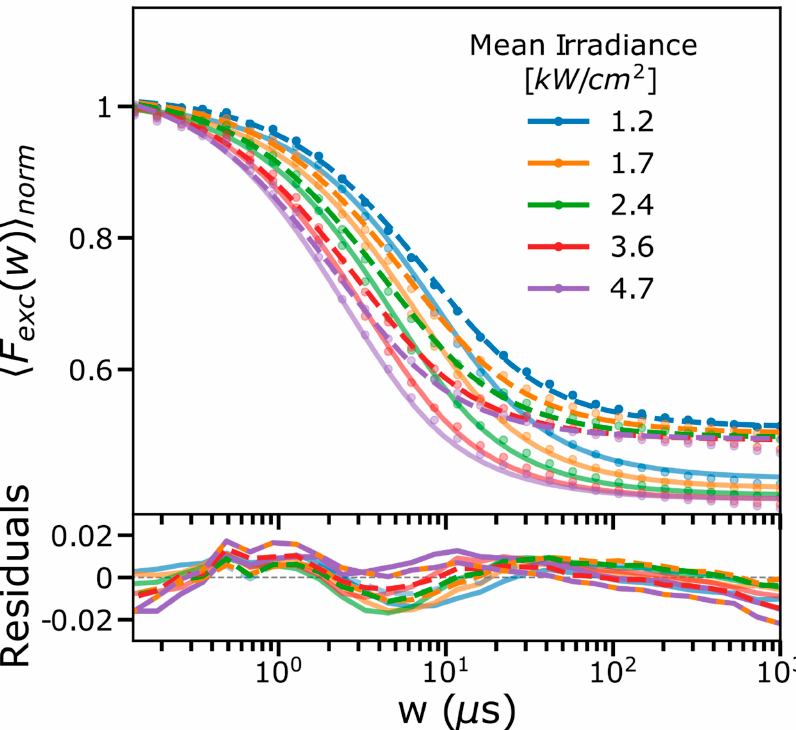
Figure 3. TRAST curves recorded under different mean Φ exc (638 nm excitation) and using two different emission filters: 645–680 nm (B ‐ filter, data: dim circles; fitted curves: dim thick lines) and 690–750 nm (R ‐ filter, data: circles; fit: thick dashed lines). The TRAST curves were globally fitted, as described in the main text. Fitting residuals are shown in the lower subplot.